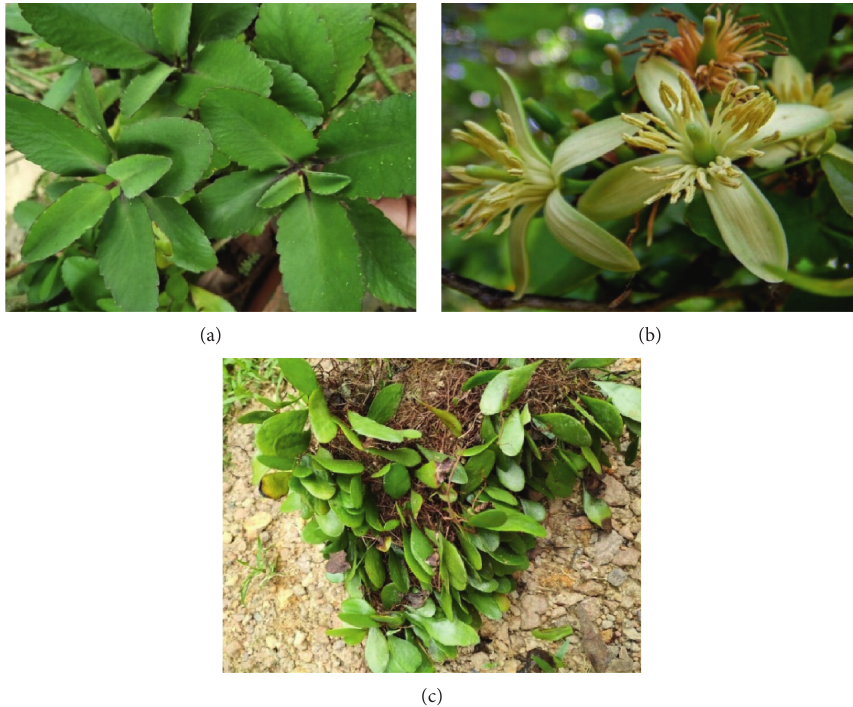
Figure 1: Three plants, Kalanchoe laciniata leaves (Crassulaceae, “Akkapana”) (a), Aegle marmelos flowers (Rutaceae, “Beli”) (b), and Drymoglossum piloselloides leaves (Polypodiaceae, “Kaasi pethi”) (c) are shown with their respective family name, local name, and the plant part used in the